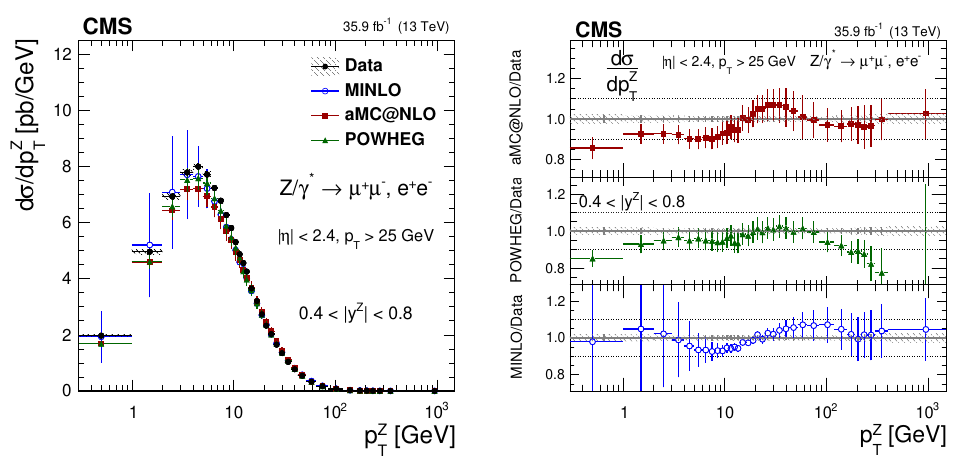
Figure 10 . The measured absolute cross sections (left) in bins of p Z for the 0 : 4 < j y Z j < 0 : 8 region. T The ratios of the predictions to the data are also shown (right). The shaded bands around the data points (black) correspond to the total experimental uncertainty. The measurement is compared to the predictions with MadGraph 5 a mc@nlo (square red markers), powheg (green triangles), and powheg - MINLO (blue circles). The error bands around the predictions correspond to the combined statistical, PDF, and scale uncertainties.